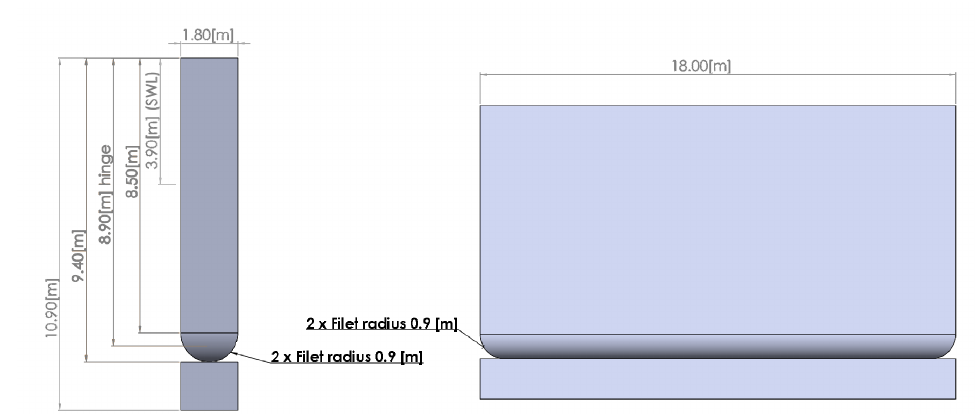
Figure 1. WEC–Sim’s depiction of the OSWEC [40]. The device is a flap style WEC operating in pitch, with the bottom rectangle representing the base and the top, larger rectangle representing the